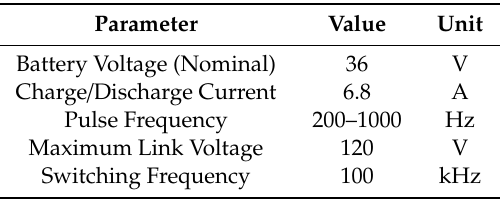
Table 1. Specifications of the pulse